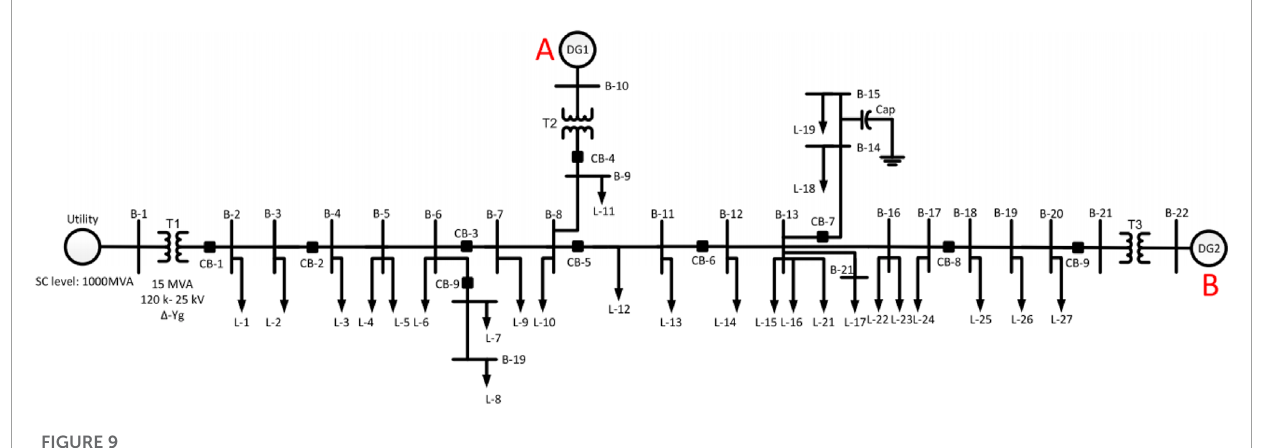
FIGURE 9 Single line diagram of distribution feeder.